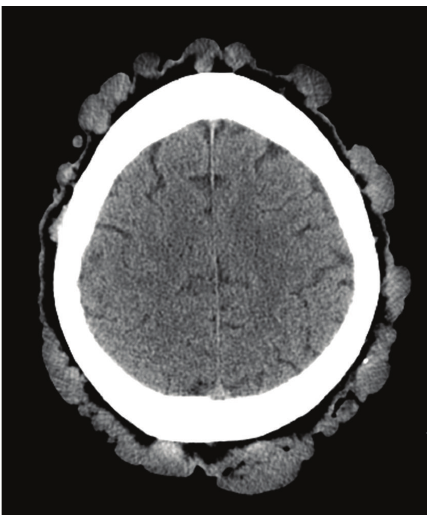
Figure 2: Noncontrast head CT: multiple nodular smooth surfaced well-demarcated soft tissue lesions arising from the scalp.